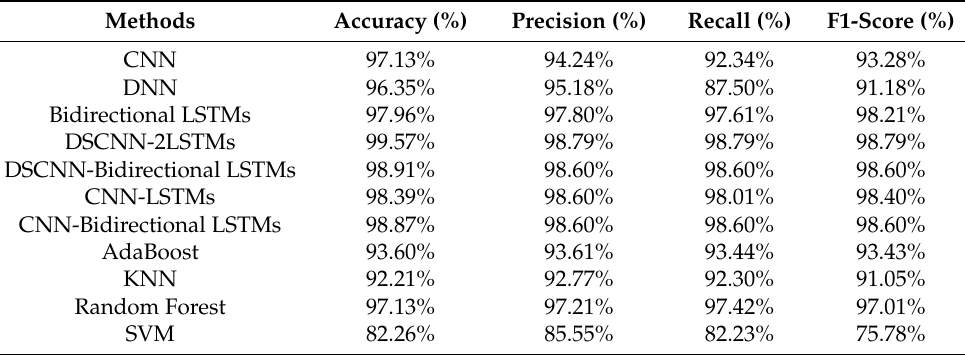
Table 9. The Performance of DSCNN-2LSTMs and other models on binary classification